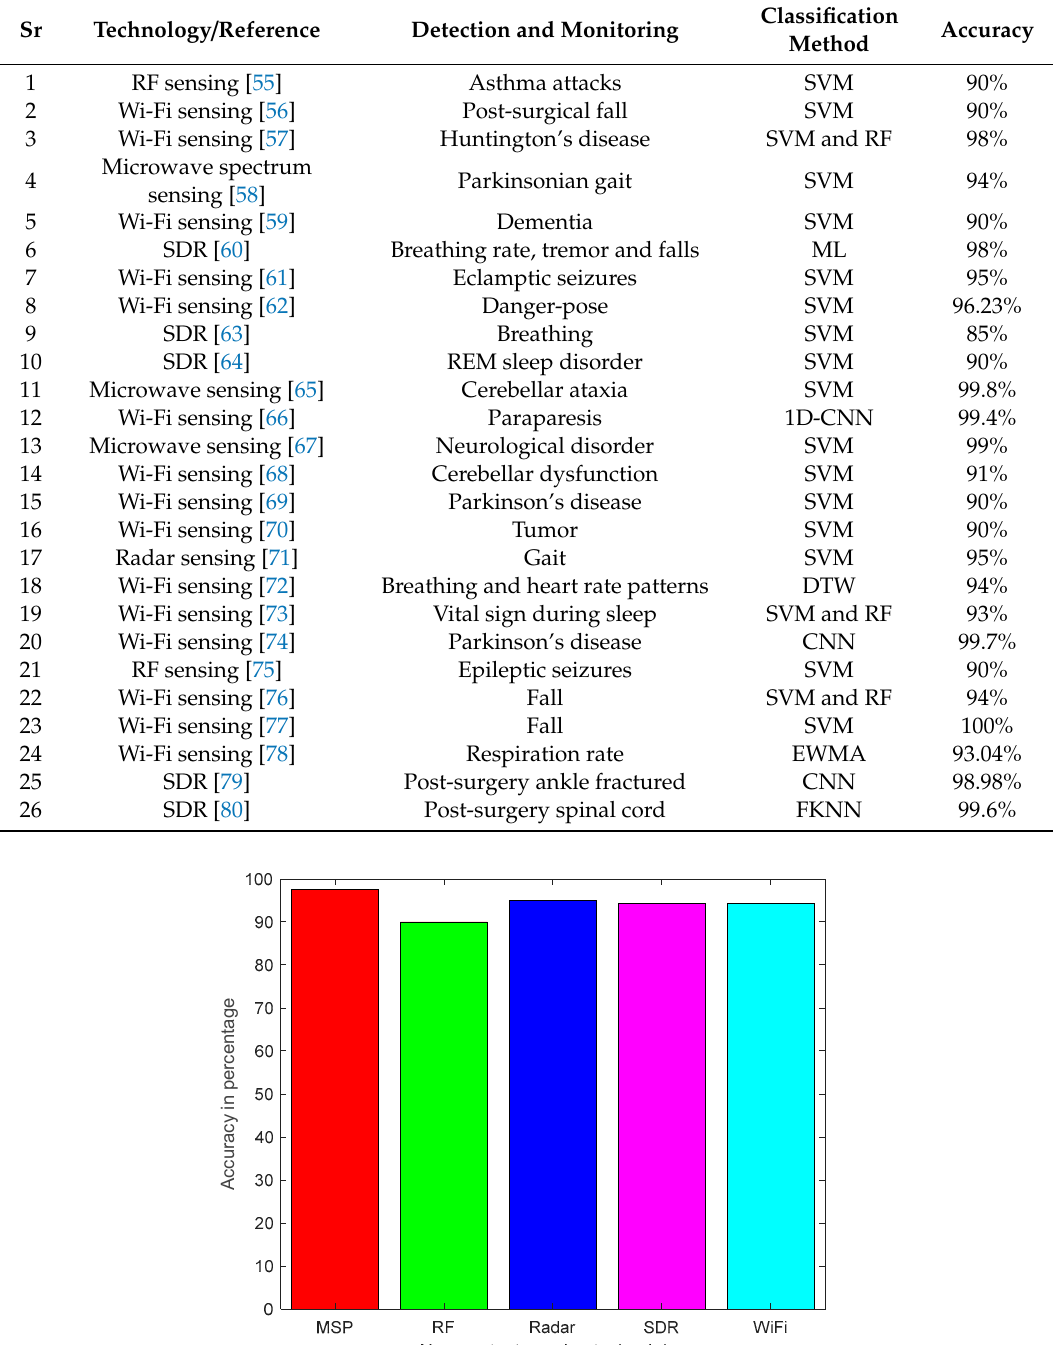
Table 4. Summary of existing contributions in diagnosis of symptoms and monitoring of health.